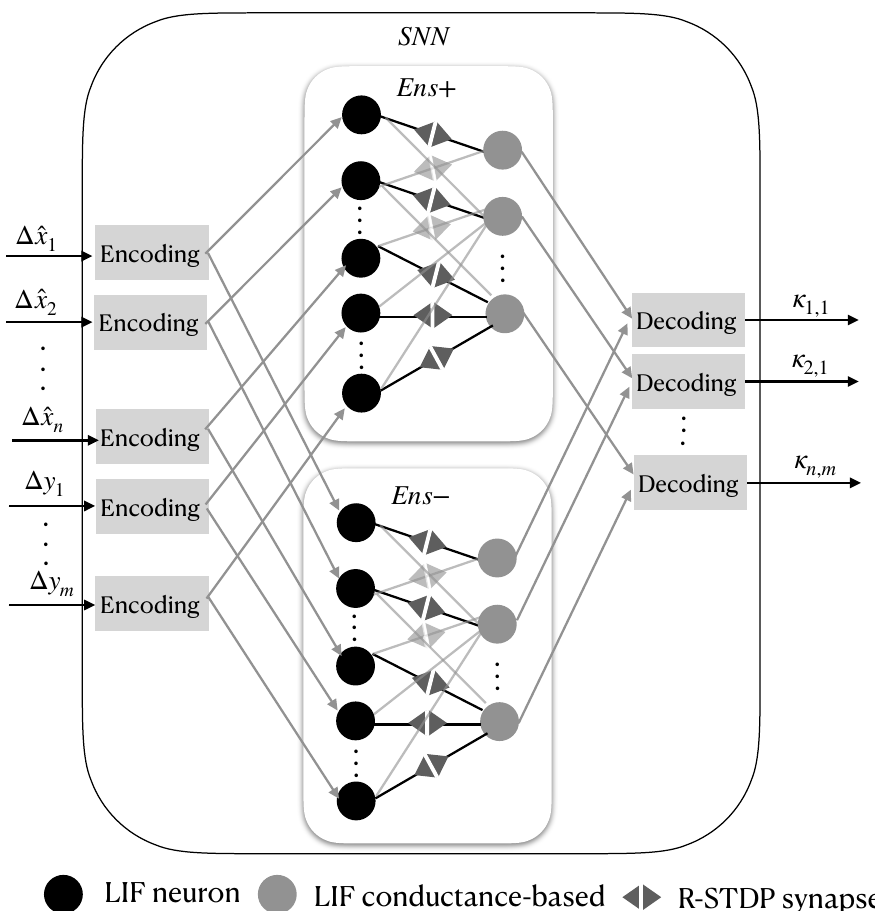
Figure 5. Proposed SNN network architecture for finding the values of the Kalman gain